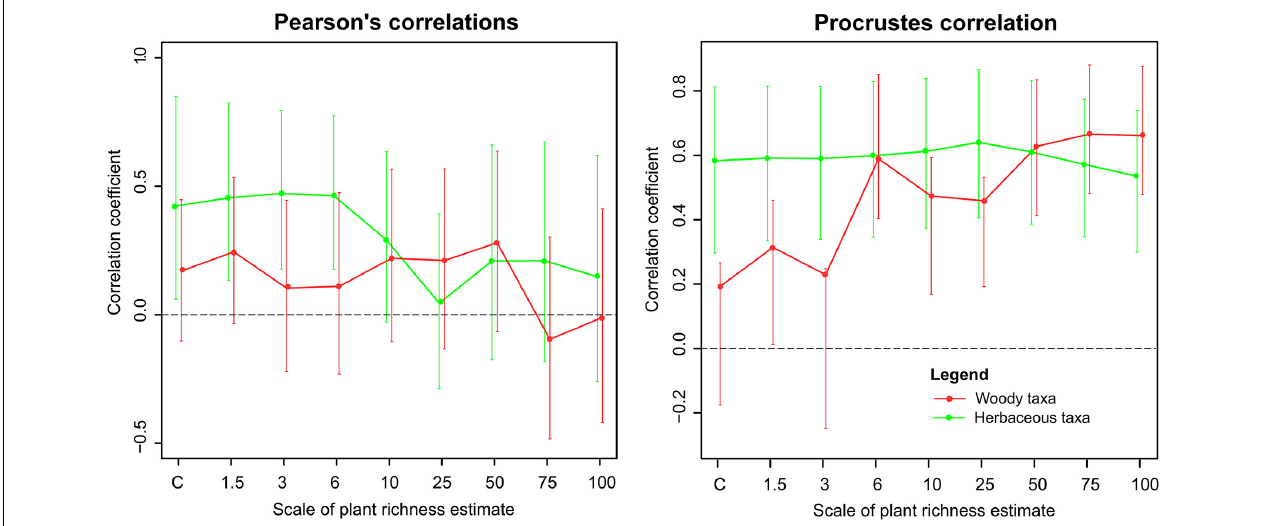
FIGURE 2 | Pollen–plant richness and composition correlations. Y -axis: the values of Pearson’s correlation coefficients (for richness on the left) and Protest correlations (for vegetation composition on the right). X -axis: the radius of plant estimate. Vertical lines indicate bootstrapped 95% confidence intervals for the correlations.